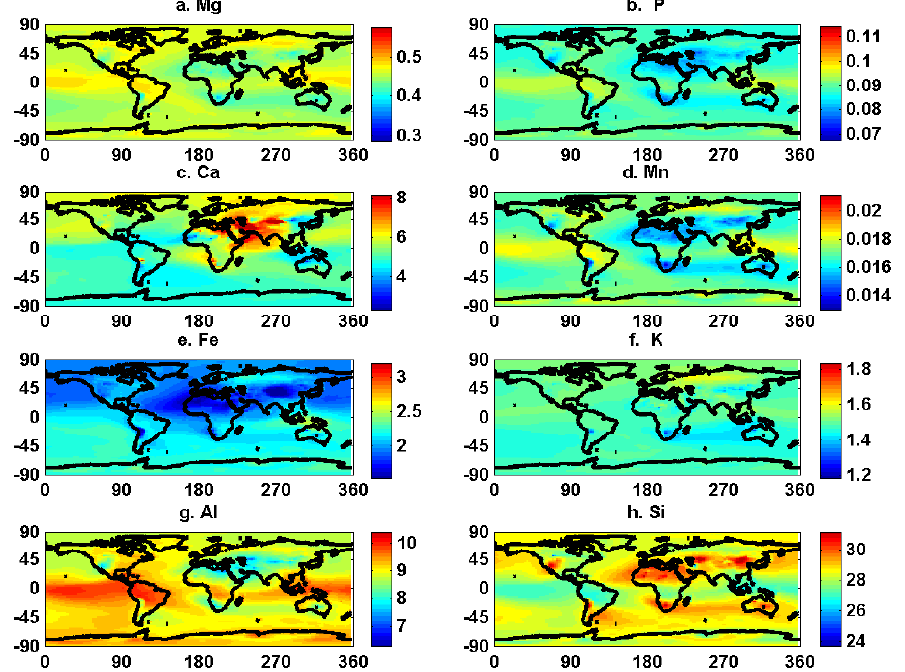
Figure 4. Percentages of elements in dust concentration (mass %): (a) Mg, (b) P, (c) Ca, (d) Mn, (e) Fe, (f) K, (g) Al, (h) Si. Elemental percentages shown here are calculated using the annual mean element concentration divided by the annual mean dust concentration.